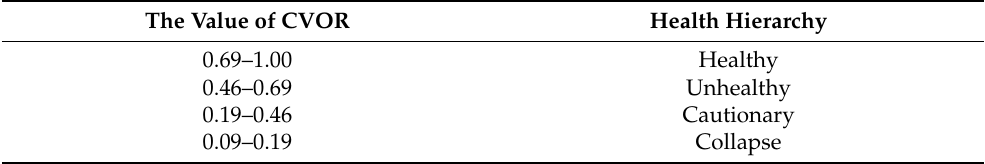
Table 3. The thresholds of four grassland ecosystem health hierarchies.